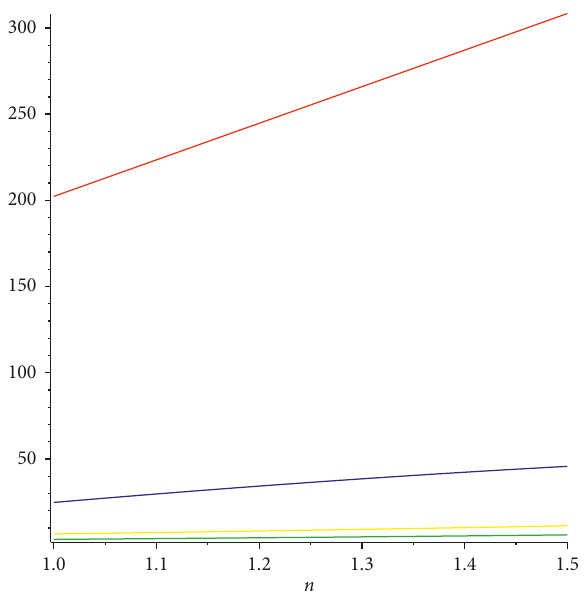
P n n , PETIM, DPZ n , and PETAA.